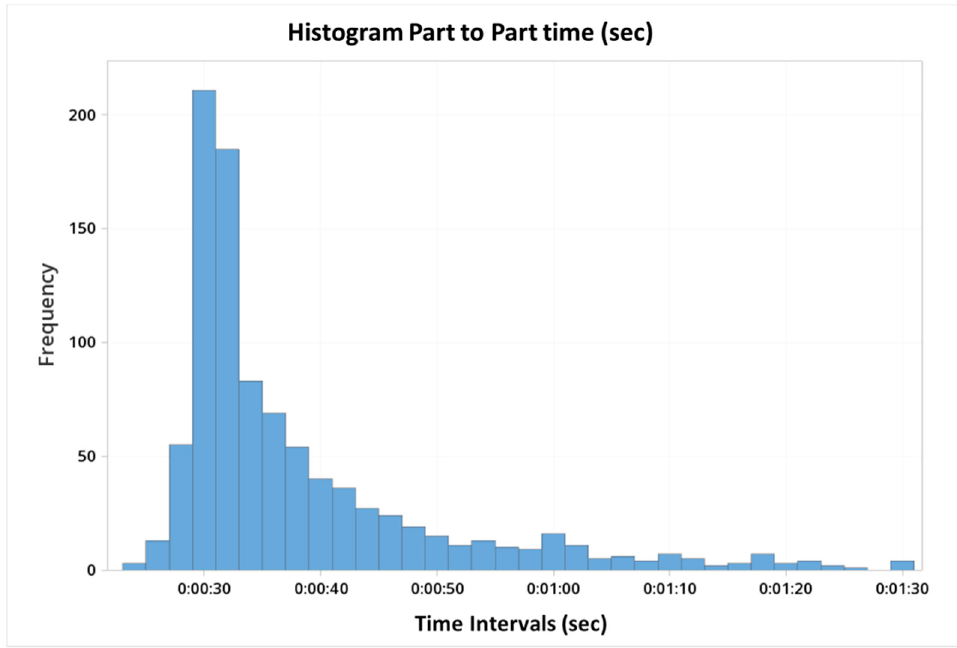
Figure 14. Part measurement cycle time on shop floor conditions. Interval between times in which the start button is pressed in consecutive cycles.